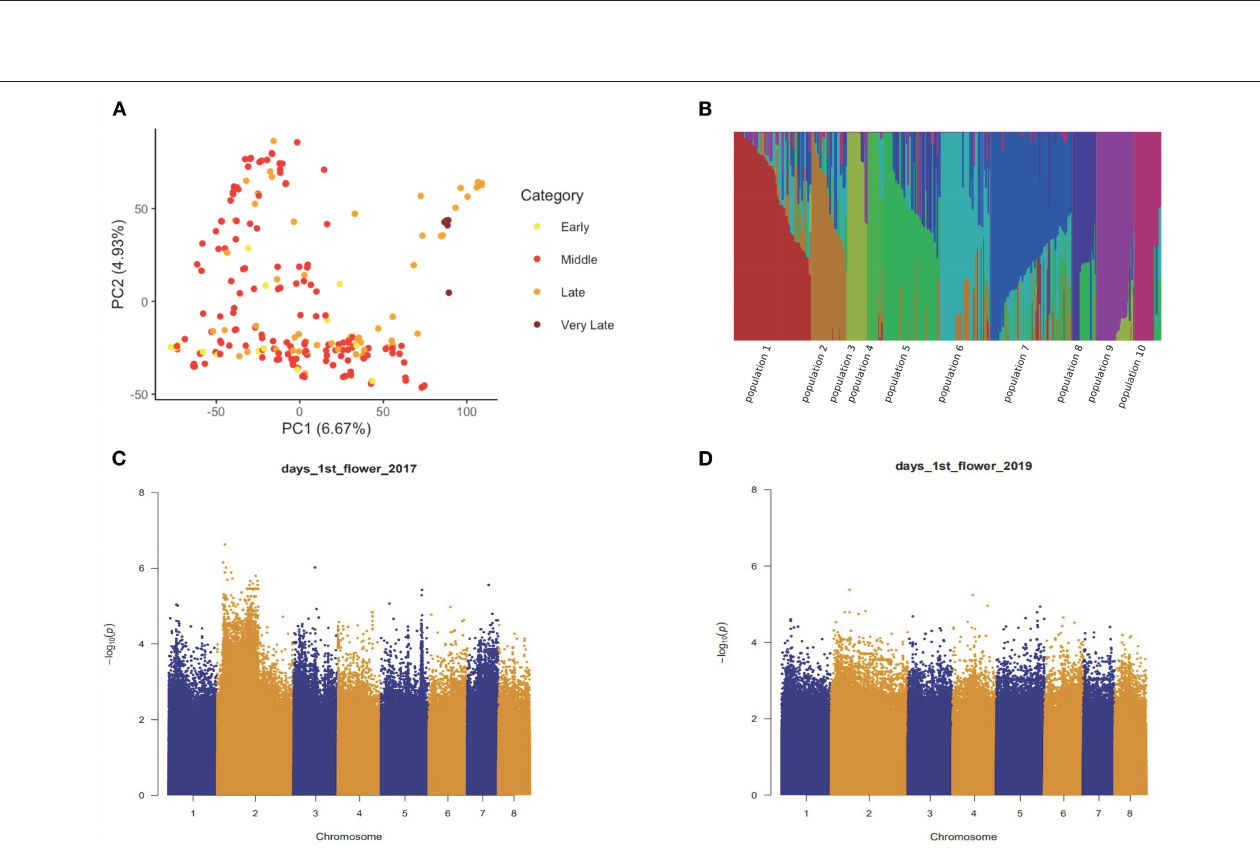
Frontiers in Plant Science |